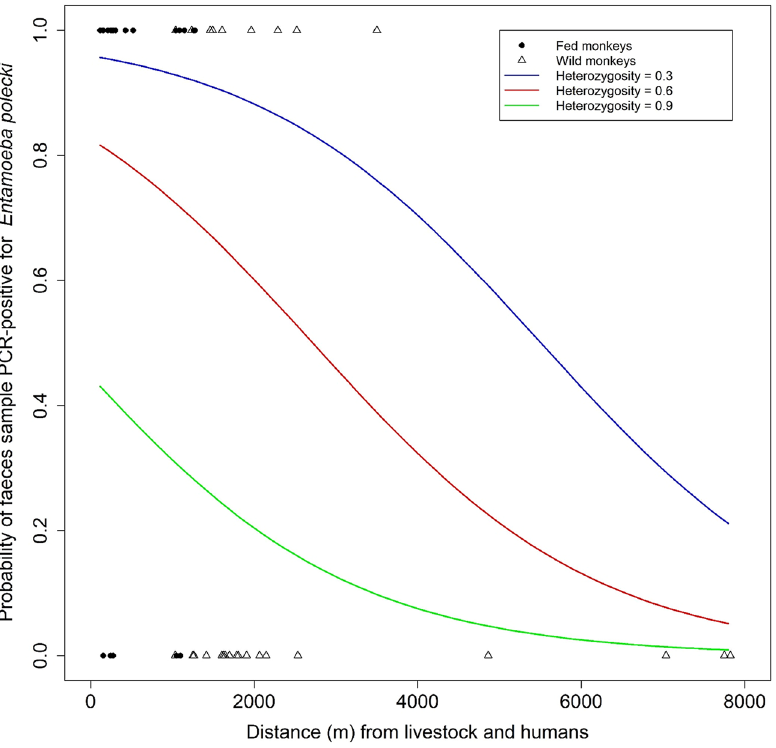
Figure 6. Model predictions for faecal samples positivity for Entamoeba polecki OTUs in 74 Yunnan snub- nosed monkeys. Probability for faecal sample to be PCR-positive for at least one Entamoeba polecki OTU in function of distance to the centroid of faecal sample locations recorded in humans and livestock, and to monkey individual heterozygosity observed over 10 microsatellites. Values of individual heterozygosity were fixed on the mean value (0.6) and the 95 percentile values of heterozygosity (0.3 and